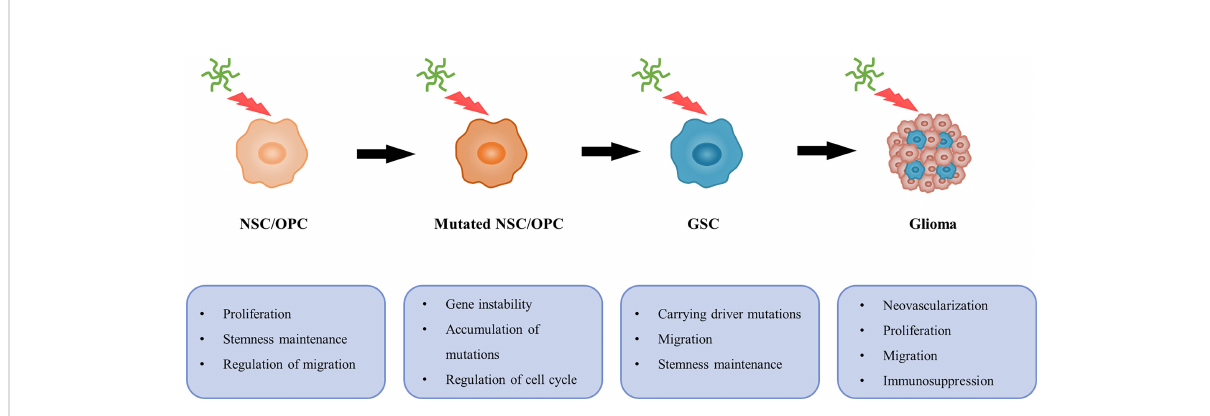
FIGURE 6 A possible relationship between TNC and gliomagenesis. In general, TNC can promote NSC/OPC proliferation, inhibit differentiation and regulate migration. However, TNC is associated with gene instability and cell cycle, and contributes to accumulation of mutations. Then NSC/ OPC carrying driver mutations are likely to undergo GSC transformation. Additionally, neovascularization, proliferation, migration and immunosuppressive effects on T cell also provide favorable conditions, which leads to